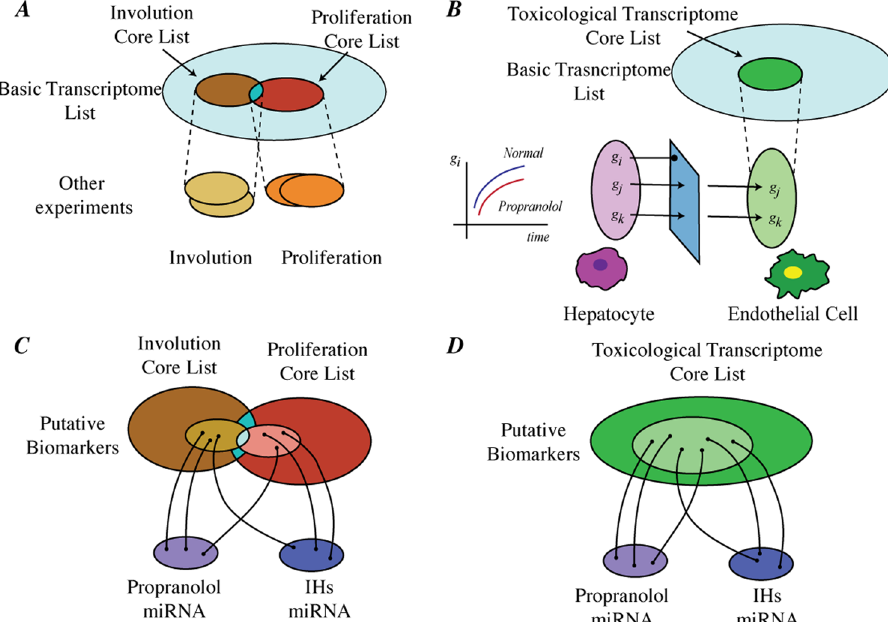
Figure 1. Schematic Representation of the Integrative Approach. ( A ) The basic transcriptome list was complemented with other experiments on IHs that distinguished the two phases of the disease. ( B ) Toxicology experiments on propranolol were provided differentially expressed genes that were further selected based on baseline mRNA expression using ENCODE datasets, and later intersected with the basic transcriptome list. ( C ) MicroRNA experiments from propranolol exposure or reported on IHs were mapped to the core lists and produced putative biomarkers. ( D ) Same microRNA strategy was used with the toxicological transcriptome core list to select putative